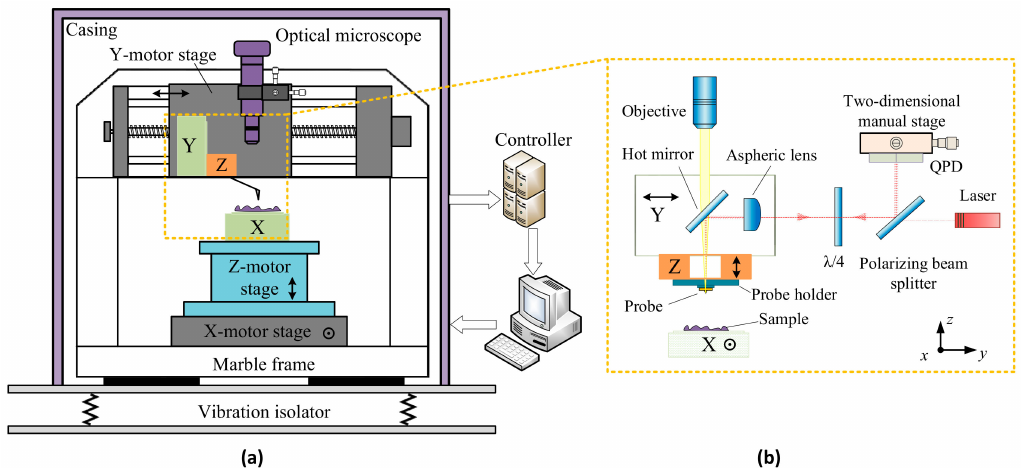
Figure 1. Schematic layout of the novel HS-AFM system. ( a ) The mechanical structure of the novel HS-AFM system; ( b ) schematic diagram of the core structure of the HS-AFM.